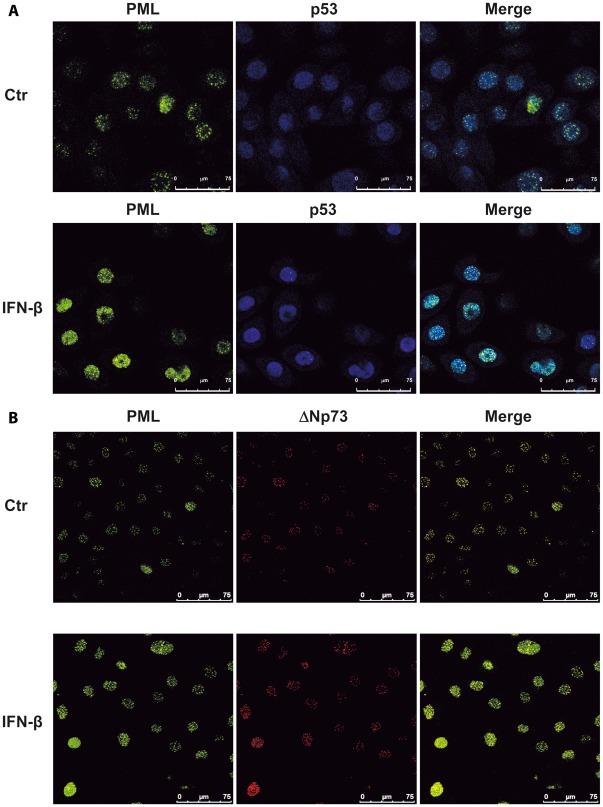
p53 and ΔNp73 co-localyze with IFN-β-induced PML into PML Nuclear Bodies.(A,B) For confocal microscopy analysis, K38 cells were cultured on glass bottom dishes (MatTek Corporation) and treated with IFN-β for 4 days. Cells were then fixed in PBS 4% paraformaldehyde for 30 min on ice, immuno-fluorescence labelling was performed as described in Materials and Methods and sample were analyzed using confocal microscope (Leica TCS SP5).